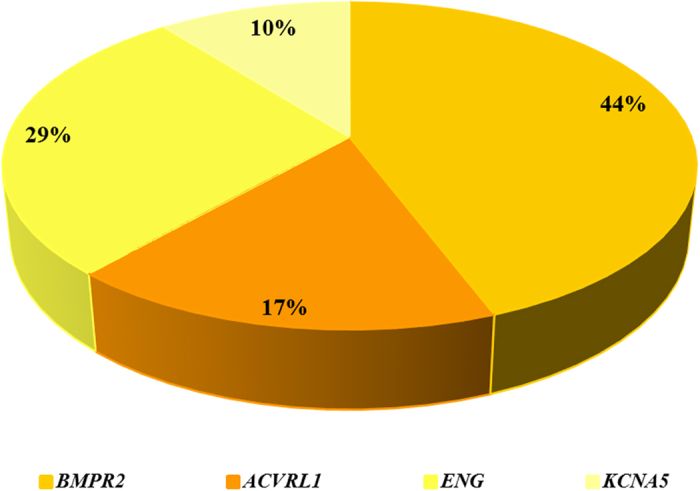
Graphical representation of the four genes analyzed here for the 57 patients included.The gene with more implication in these patients is BMPR2, followed by ENG gene and, finally, ACVRL1 and KCNA5 genes.